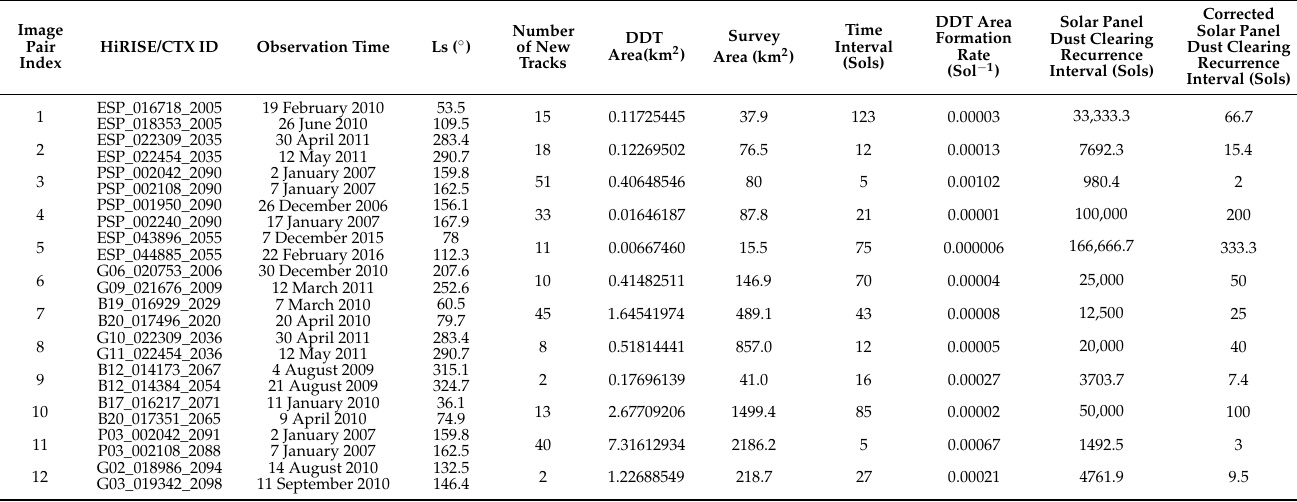
Table 5. Summary of DDT area formation rates and solar panel clearing recurrence intervals in 12 image pairs. The image pair index is consistent with that in Figure